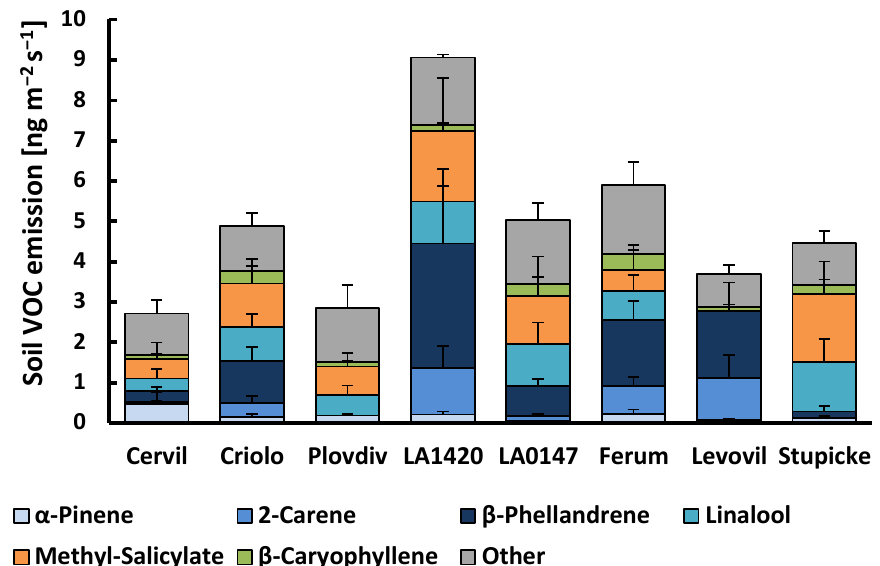
Figure 2. VOC emissions from the soil surface of the eight accessions of the MAGIC tomato popula- tion. Column sections show the mean emissions + SE ( n = 3–4) of the six major emitted compounds and the sum of all other compounds. There was no significant difference between genotypes for individual VOCs or the sum of VOC emissions (Kruskall–Wallis tests, p > 0.05). Analyses of root extracts revealed the presence of six VOCs in low concentrations, of which only β-phellandrene and methyl-salicylate were also found in the soil emissions. Two benzenoïds phenyl-acetaldehyde and guaiacol, the acyclic monoterpene alcohol ge- raniol and one unidentified aldehyde, were the other stored VOCs inside roots (Table 2). The two major stored compounds, phenyl-acetaldehyde and methyl-salicylate, scaled positively with each other (R 2 = 0.77) and to a lesser extent with guaiacol (R 2 : 0.52 and 0.30, data not shown). There were no apparent correlations between the amounts of the other stored VOCs. As for belowground emissions, the VOC contents from root extracts were highly variable among plant replicates and, hence, no significant genotype effect could be seen from our data. On average, the total amount of VOCs stored in the roots was 2.55 ± 0.38 µg g −1 FW. Table 2. VOC contents in root extracts (µg g −1 root fresh weight) of the eight tomato genotypes. Data are means of 3–4 plant replicates ± SE. There was no significant difference between genotypes ( p > 0.05; ANOVA on the sum of VOCs and Kuskall–Wallis tests on individual VOCs). VOC